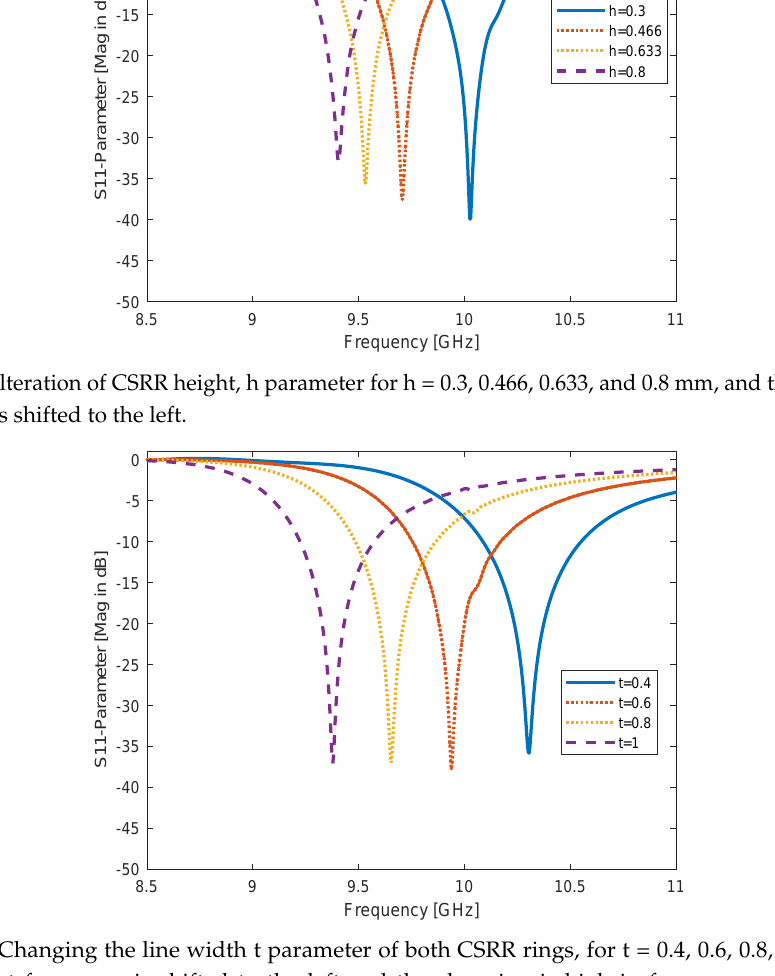
Figure 10. Changing the line width t parameter of both CSRR rings, for t = 0.4, 0.6, 0.8, and 1 mm, the resonant frequency is shifted to the left and the changing is high in frequency according to this